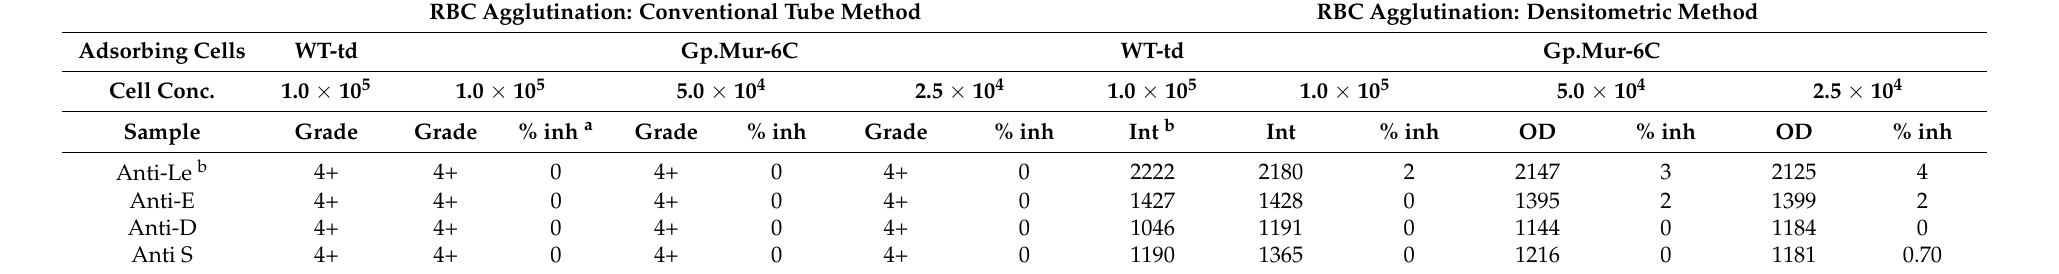
Table 2. Summary of hemagglutination inhibition for nonspecific